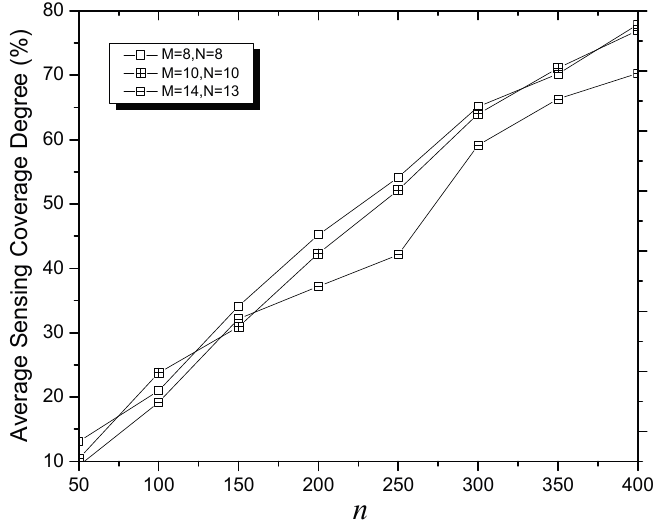
Figure 6. Average SCD versus network size with the fixed number of points of interest.